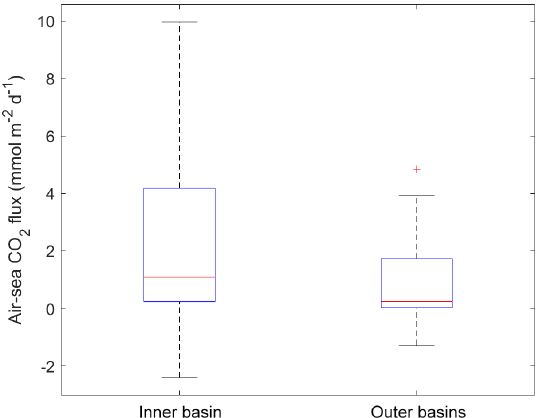
Figure 7. Box-plot of the air–sea CO 2 fluxes from all data in the two subsections of the study area (Inner basin and Outer basins). The red line is the median, the box spans the interquartile range (25– 75 percentiles) and the whiskers show the extreme data points not considered outliers. One outlier is identified by the red +